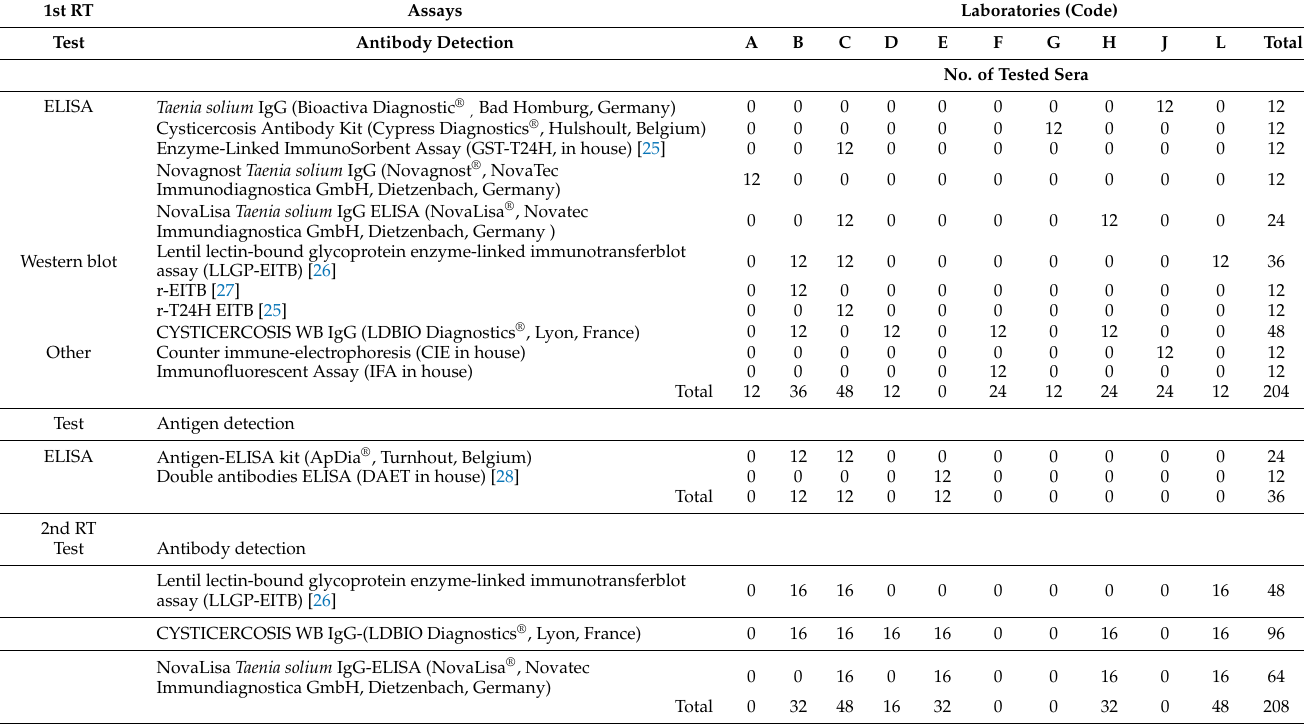
Table 4. Serological tests and number of tested samples performed by the laboratories in the course of the first and second Ring Trials